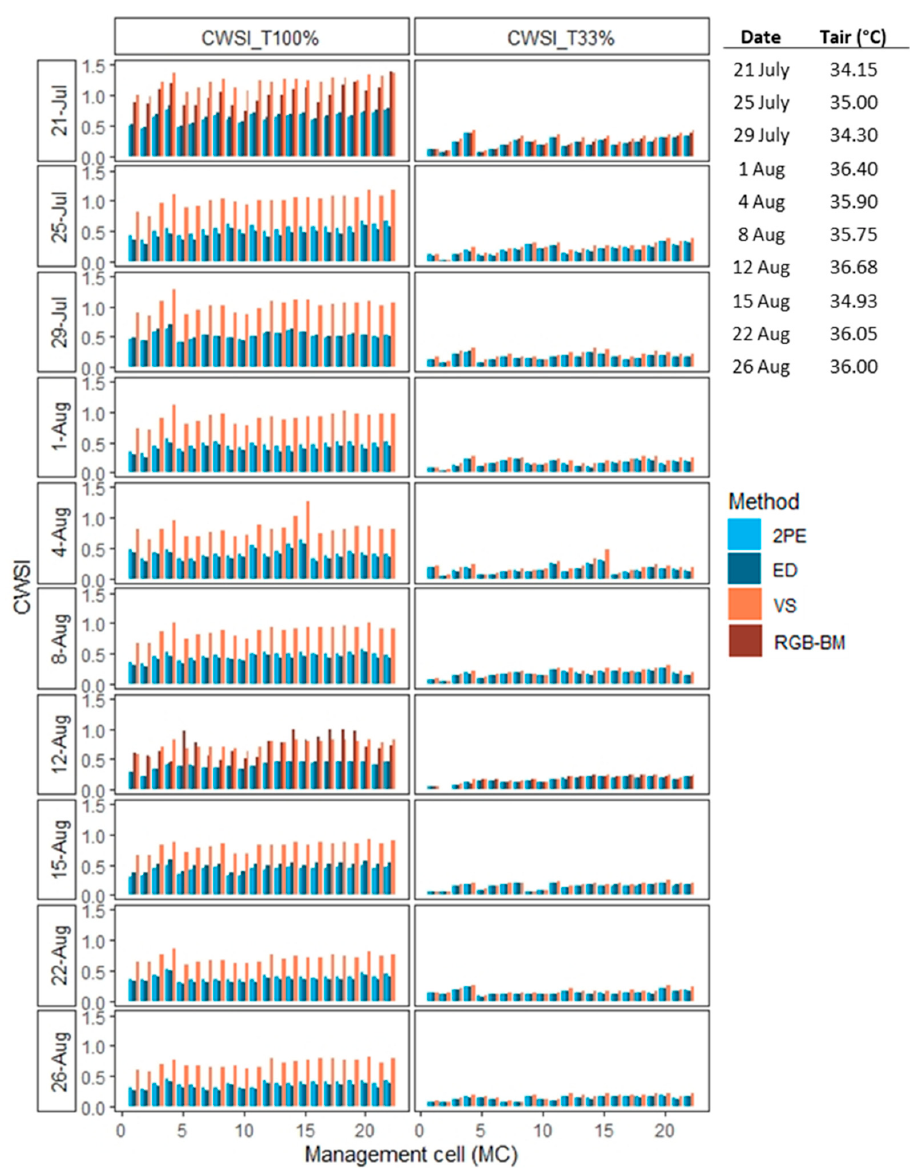
Figure 7. Crop water status index (CWSI) with Tcanopy (°C) calculated using the average 100% (CWSI_T100%) and the average of the coolest 33% (CWSI_T33%) of canopy pixels. Twet = lowest 5% of canopy pixels, and Tdry = Tair + 2 °C. Values per management cell (MC) between 21 July and 26 August 2019 for the canopy extraction methods: 2-pixel erosion (2PE) (turquoise), edge detection (ED) (dark blue), vegetation segmentation (VS) (coral), and RGB binary masking (RGB-BM) (brick red). The table insert shows the air temperature (Tair (°C)) values.